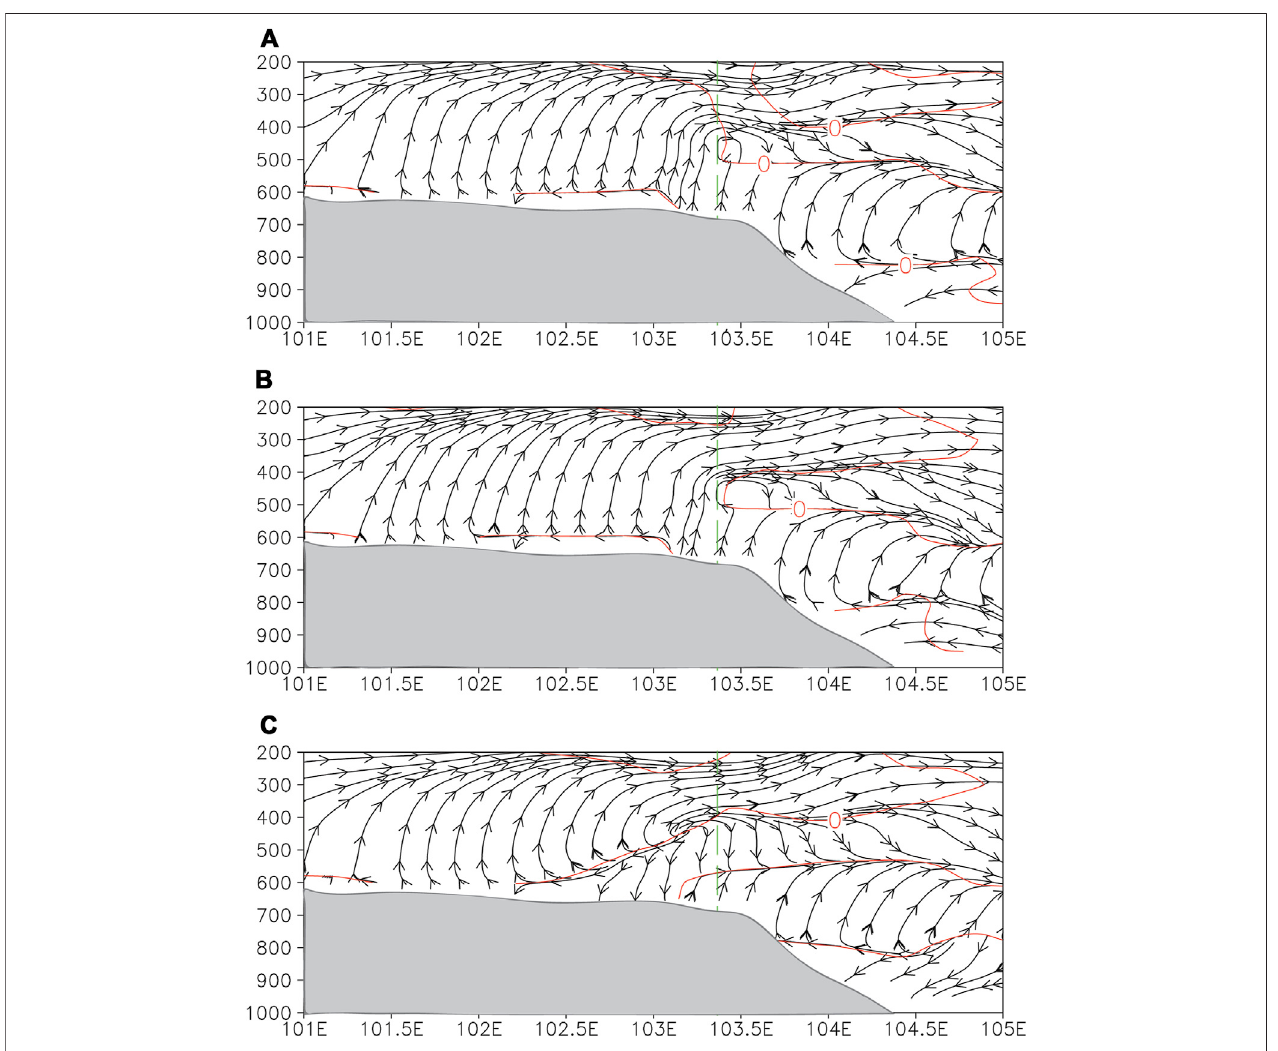
FIGURE 12 | West – east-oriented vertical cross-section of the simulated wind circulation (stream, units: m s − 1 ) along the epicenter at latitude 31.01 ° N for 18:00 UTC on May 12, 2008 for (A) the CTL experiment, (B) the TMP+1.5 experiment and (C) the TMP − 1.5 experiment. The green dashed line denotes the epicenter of the earthquake at longitude 103.42 ° E; the gray shaded area represents the topography and the red solid lines are the contours of zero vertical velocity (units: m s − 1 ).